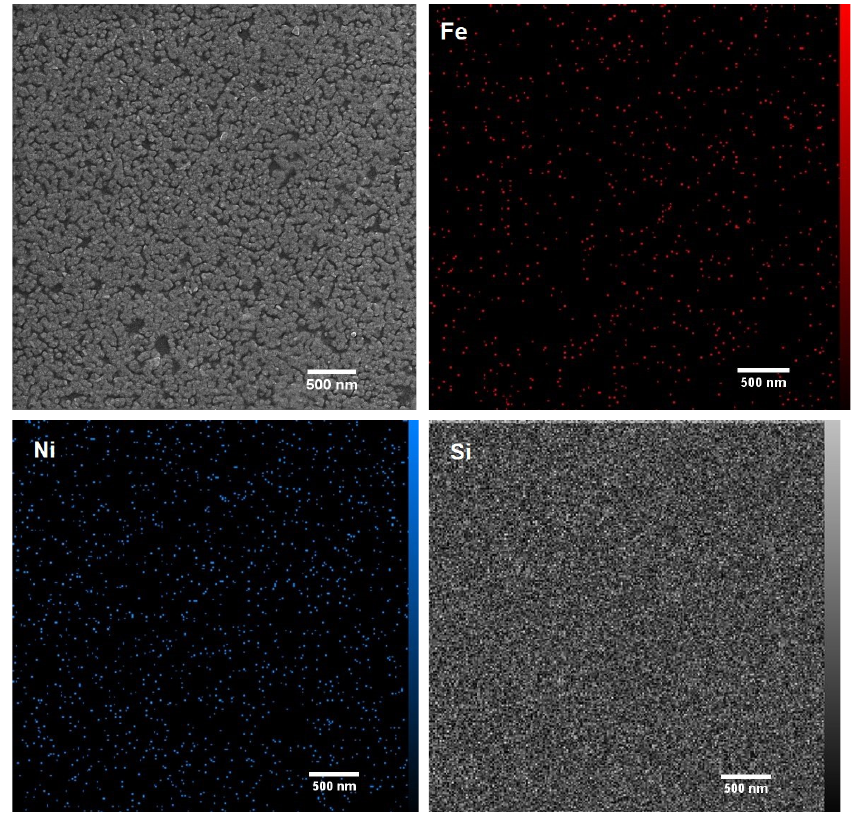
Figure 1. Morphology and element distribution map of sample S1.